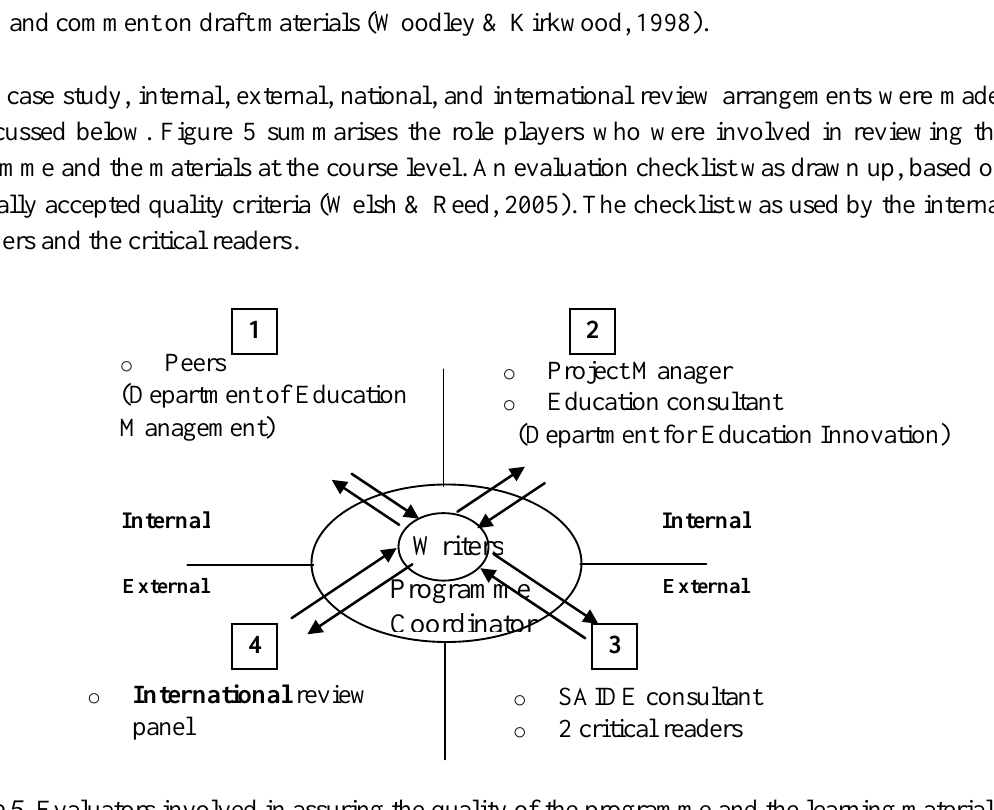
Figure 5 . Evaluators involved in assuring the quality of the programme and the learning